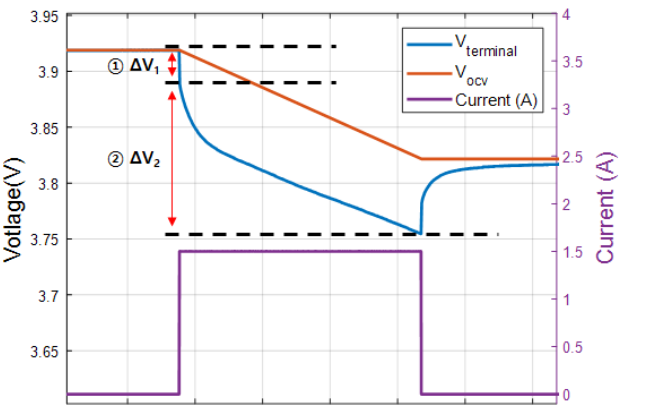
Figure 6. Voltage, OCV, and current waveform when SOC decreased from 70% to SOC 60%.